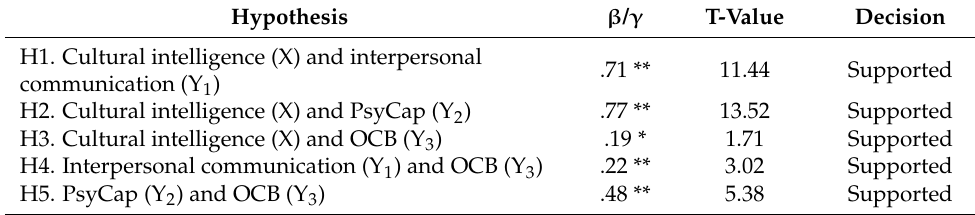
Figure 2. T-value structural model. Table 5. Hypothesis testing results.